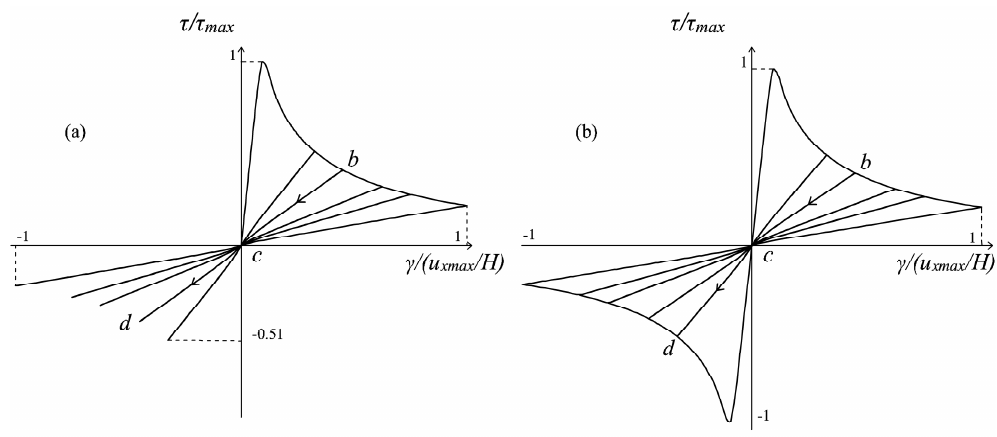
Figure 12. Structural response for the problem represented in Figure 5a, considering a loading history for the horizontal displacement u x composed of five cycles: ( a ) damage formulation presented in Section 2 and ( b ) multidirectional damage model.